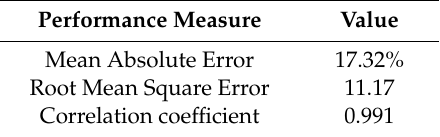
Table 6. Performance of the ANN model in predicting fluxes for the datasets given in Table